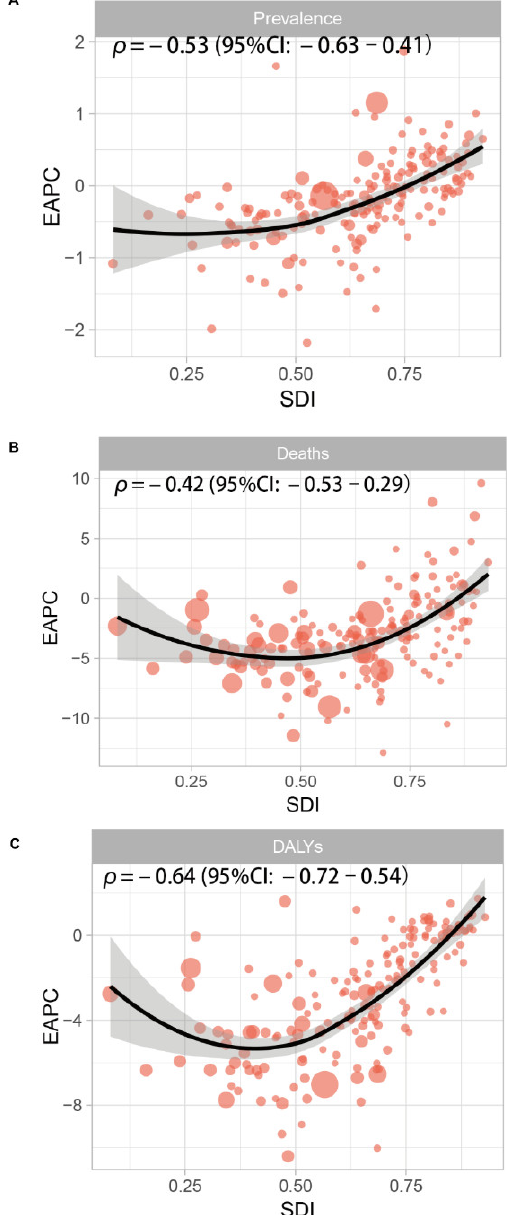
Figure 5. The association between the socio-demographic index (SDI) and estimated annual percent- age change (EAPC) in age-standardized prevalence rate (ASPR), age-standardized death rate (ASDR), and age-standardized disability-adjusted life years of protein–energy malnutrition. SDI (2019) was negatively associated with EAPC in ( A ) ASPR ( ρ = − 0.53, p < 0.001), ( B ) APSR ( ρ = − 0.42, p < 0.001), and ( C ) age-standardized DALY ( ρ = − 0.64, p < 0.001).